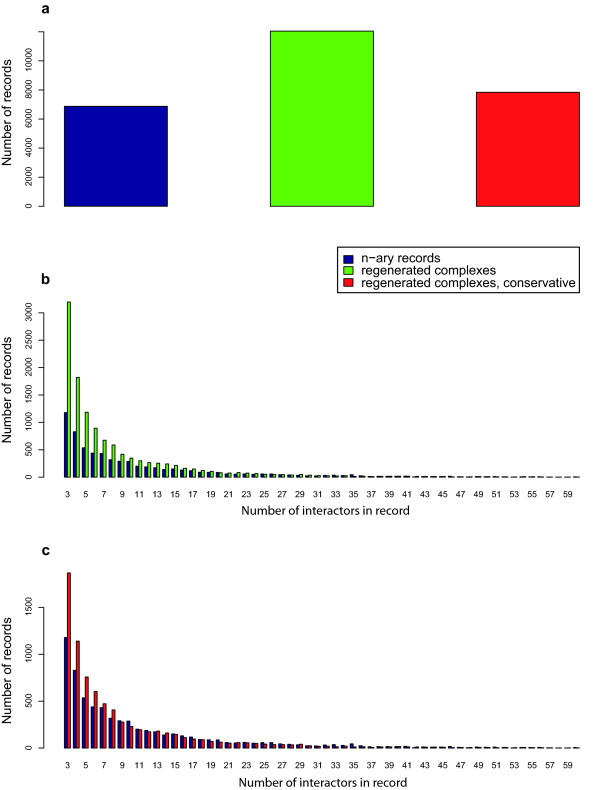
Number and size of yeast n-ary records versus regenerated complexes. a. Number of binary records in yeast (red), n-ary records regenerated from binary interaction records that are possibly represented n-ary data (green) and another set of regenerated n-ary records that are more conservative (red). There are 43% more yeast regenerated complexes from binary-represented complexes than yeast reported complexes (n-ary records) in iRefIndex. b. Distribution of complex sizes for n-ary records and regenerated complexes. Both distributions are skewed to the left, with the regenerated one being more strongly skewed. c. Distribution of complex sizes for n-ary records and a more conservative set of regenerated complexes. Records having more than 60 interactors are not shown in panels b and c.